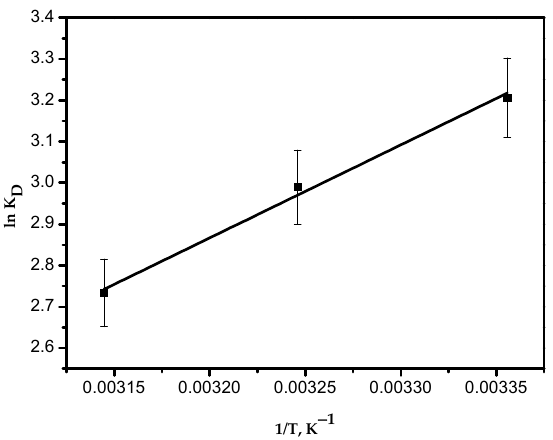
Figure 12. Plot of ln K D versus 1/T. Table 4. Thermodynamic parameters of the adsorption of Pb(II) ions on AILP.